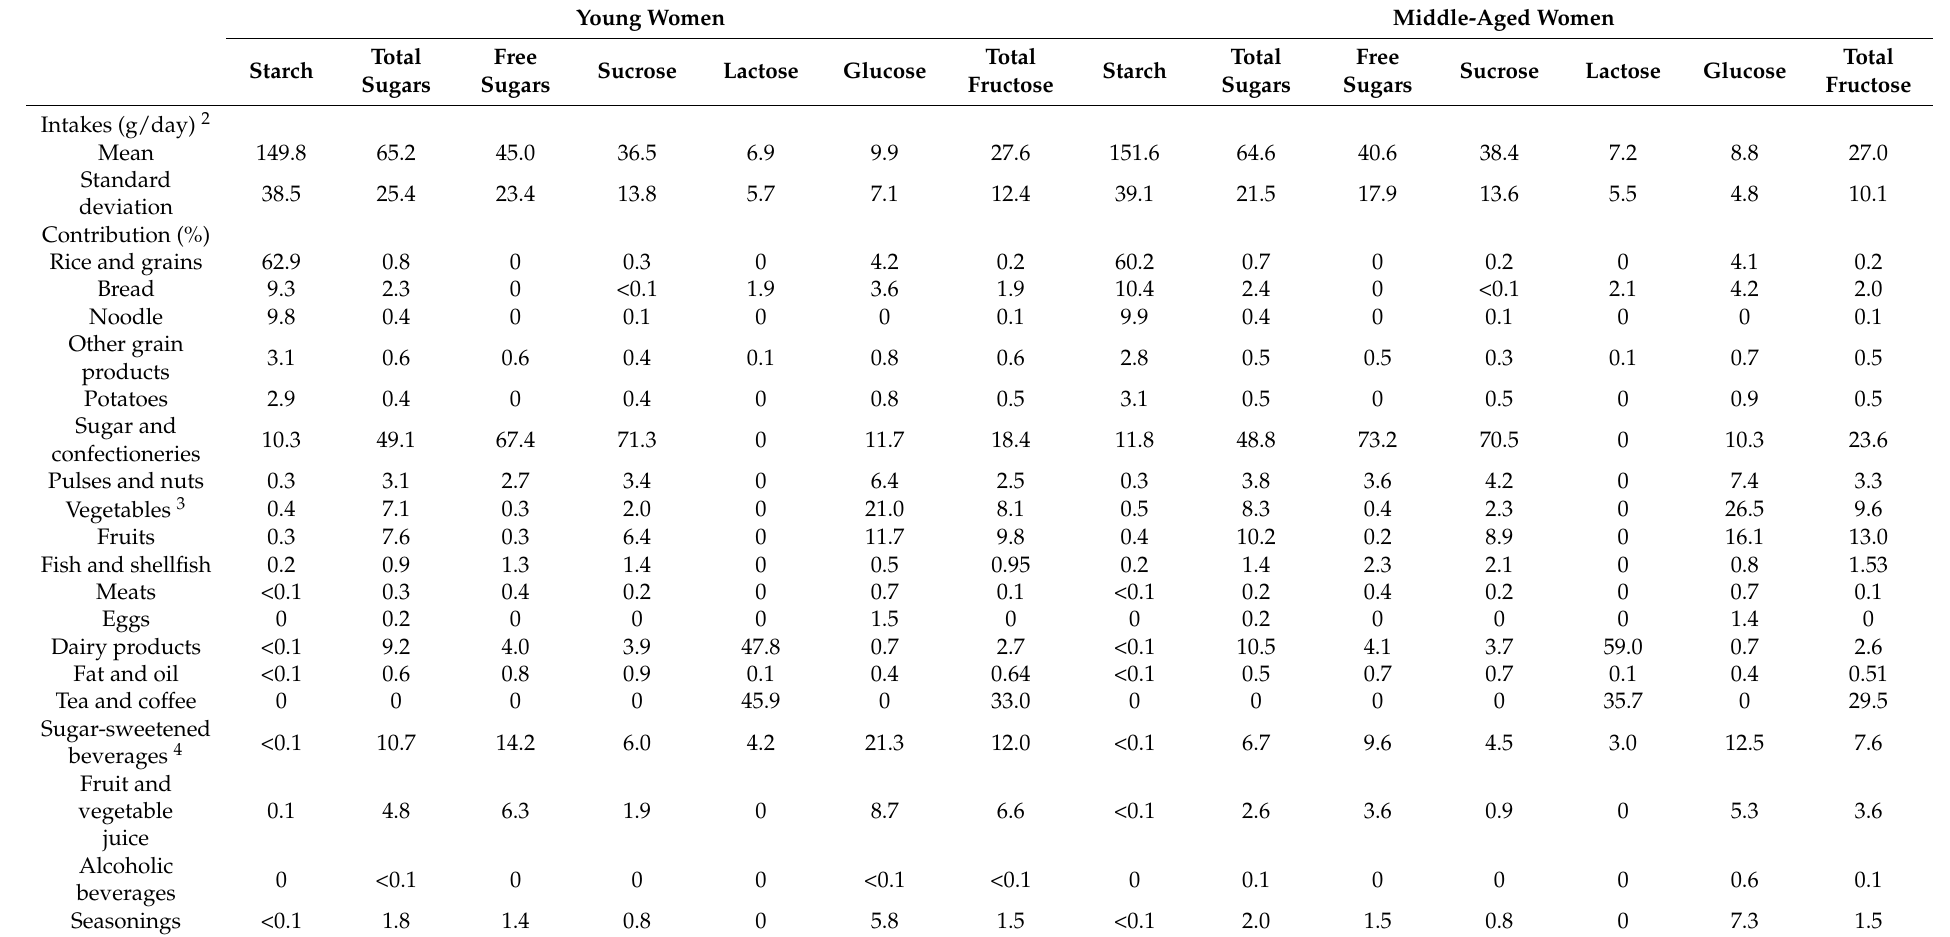
Table 1. Contribution of each food group to the intakes of starch and sugars in 3963 young and 3826 middle-aged Japanese women 1 . Young